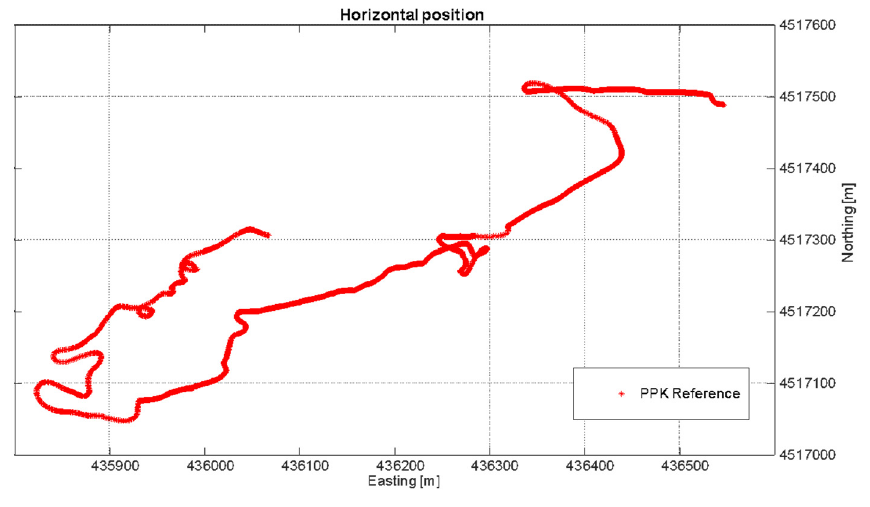
Figure 8. The horizontal positioning solutions obtained applying PPK mode and used to perform the error analysis in the kinematic